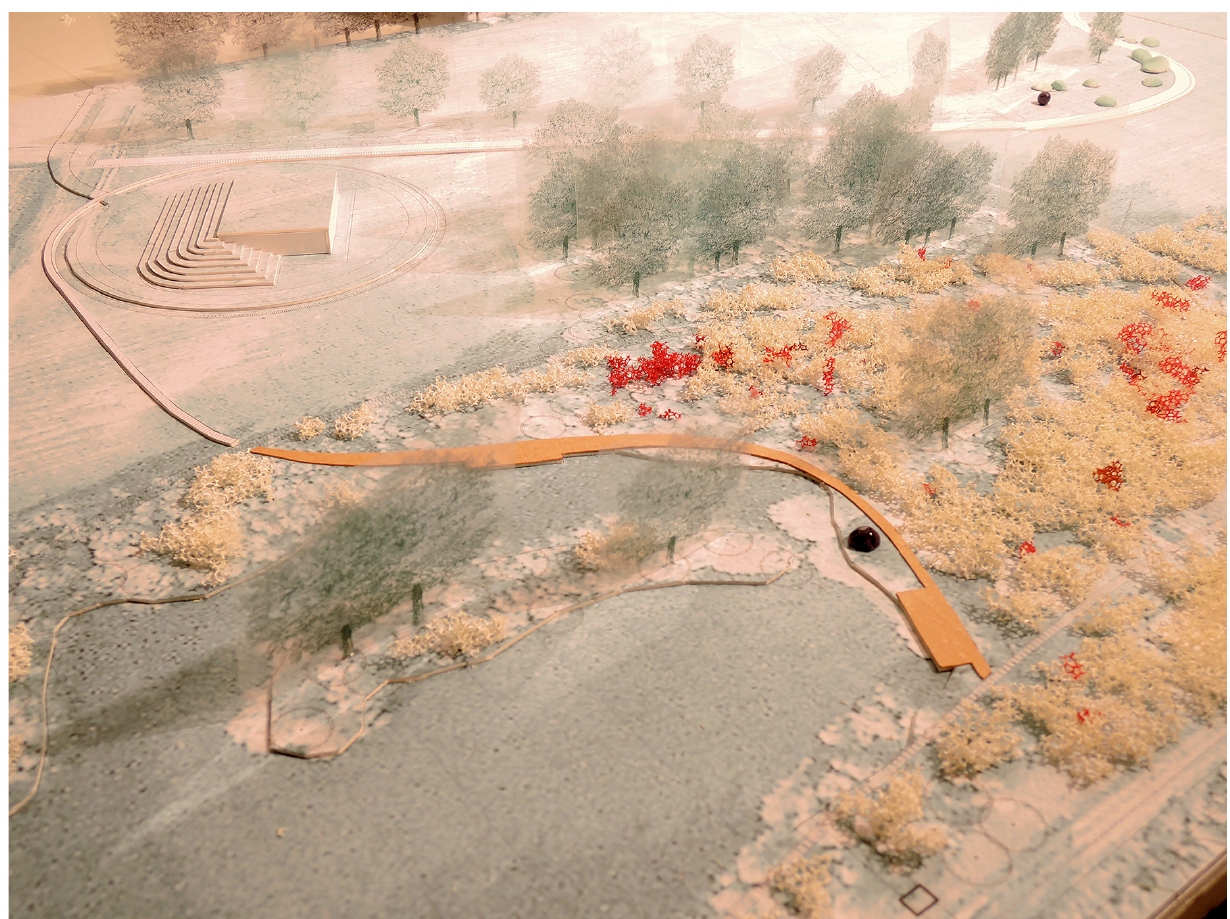
Figure 2. Dessel nuclear park. Sequences of landscapes: The wet heath. The new information center is being realized by Bovenbouw and ONO architectuur. Image credits due to the StudioPaolaViganò (P. Viganò, U. degli Uberti, V. Cox, J. de Vlam, A. Tamiazzo, C. van Maercke, K. Yoshida, Q. Zhang) and ARA (Dries Beys; 2017-ongoing